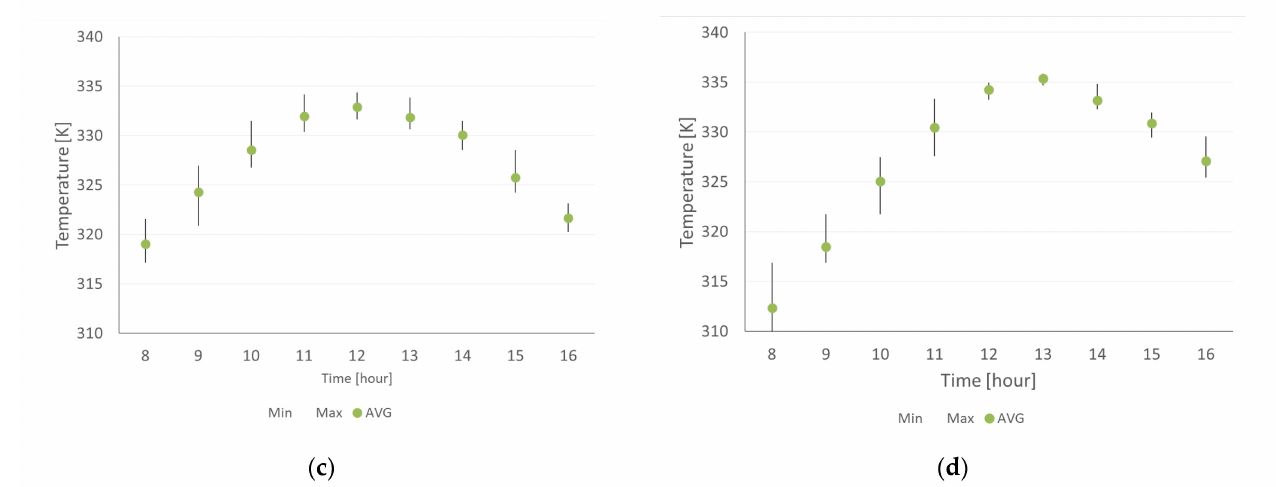
Figure 17. Minimum of average hourly temperature, maximum of average hourly tempera- ture and average hourly temperature intervals for measurements in Kelvins with collector ro- tation ( a ) 21 March 2019, ( b ) 2 April 2019 and without collector rotation, ( c ) 29 March 2019, and ( d ) 30 March 2019. (cid:17) (cid:16) T = T T (cid:104) t (cid:105) Average outlet temperature of the collectors with rotation is T = 331.63 K e e h , i (cid:17) (cid:16) s = T S (cid:104) t (cid:105) (Figure 17a,b) without rotation is T = 327.39 K (Figure 17c,d). The pro- e e h , i (cid:17) (cid:16) = (cid:104) t (cid:105) file of the differences of the average hourly temperatures determined as ∆ T e h , i (cid:17) (cid:17) (cid:16) (cid:16) T − T S (cid:104) t (cid:105) (cid:104) t (cid:105) T are at the Figure 1. The highest temperature difference represents e e h , i h , i (cid:17) (cid:17) (cid:17) (cid:17) (cid:16) (cid:16) (cid:16) (cid:16) ∆ T = 7.61 K; ∆ T = 5.74 K; ∆ T = 4.34 K. ∆ T (cid:104) t (cid:105) (cid:104) t (cid:105) (cid:104) t (cid:105) (cid:104) t (cid:105) = 4.45 e e e e h ,8 h ,9 h ,10 h ,14